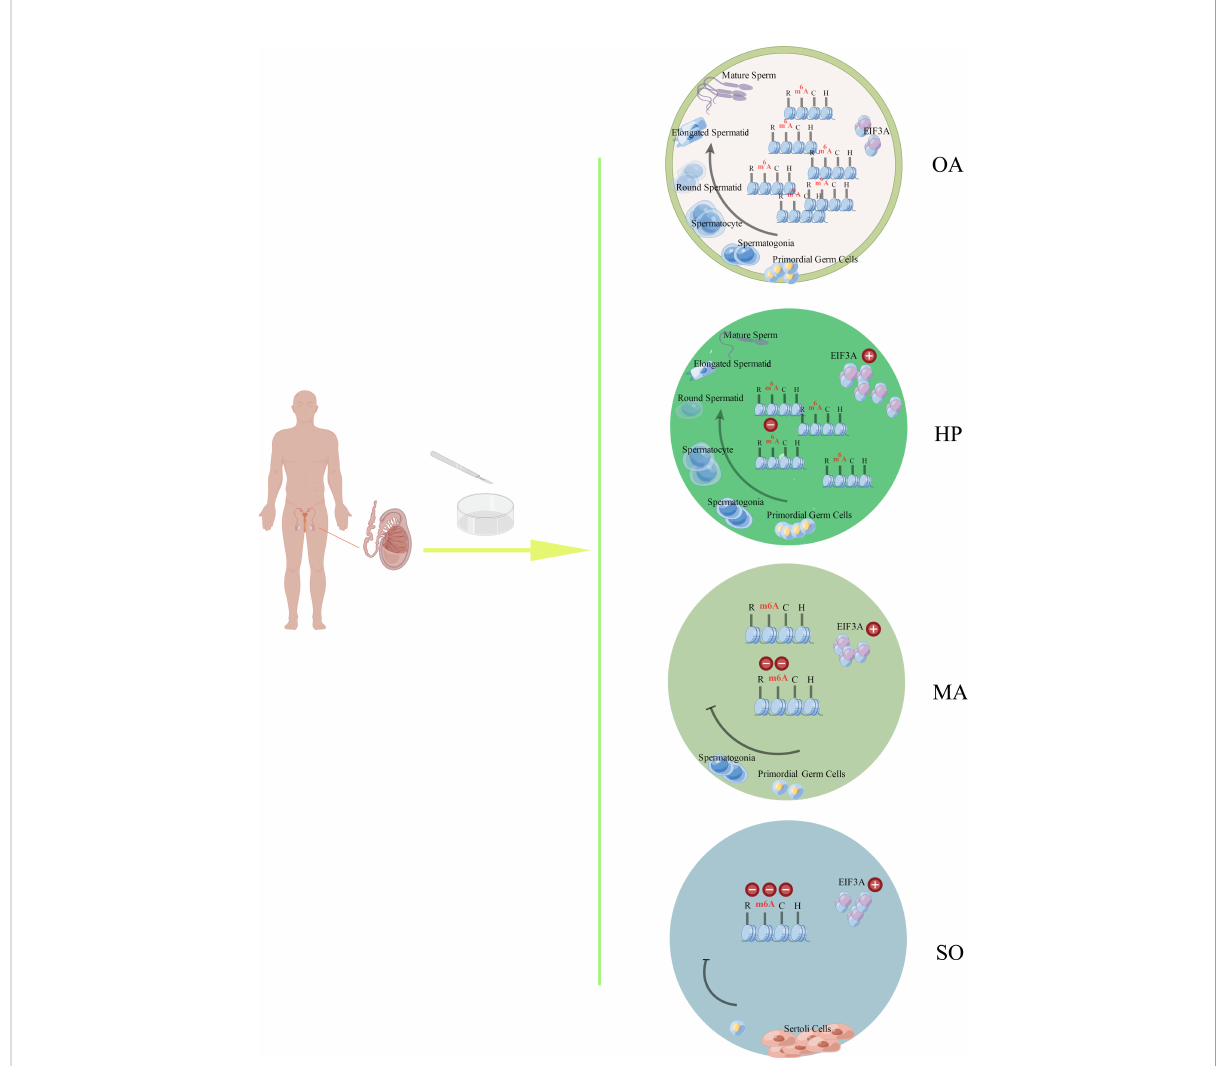
FIGURE 5 The schematic drawing of the main fi ndings from this study by Figdraw. The m 6 A expression was gradually downregulated in the testes tissues from different groups (OA, HP, MA, and SO groups) in accordance with the degree of spermatogenic dysfunction. As m 6 A reader, EIF3A was testi fi ed to be upregulated in the testes from iNOA patients, which include the patients with HP, MA, or SO. OA: obstructive azoospermia (with the successive process of normal spermatogeneis), HP, hypospermatogenesis; MA, maturation arrest; SO, Sertoli cell-only